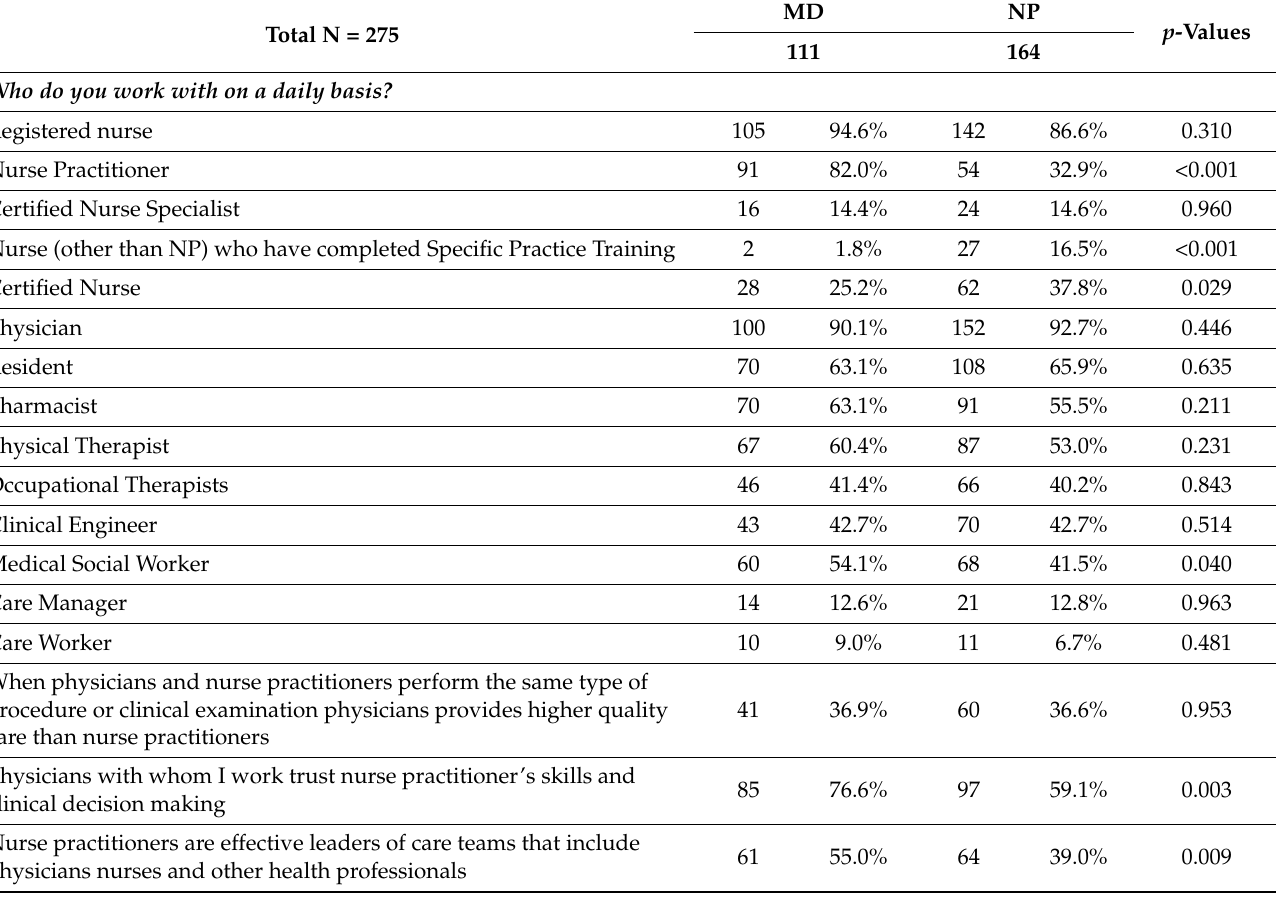
Table 3. Perceptions of the